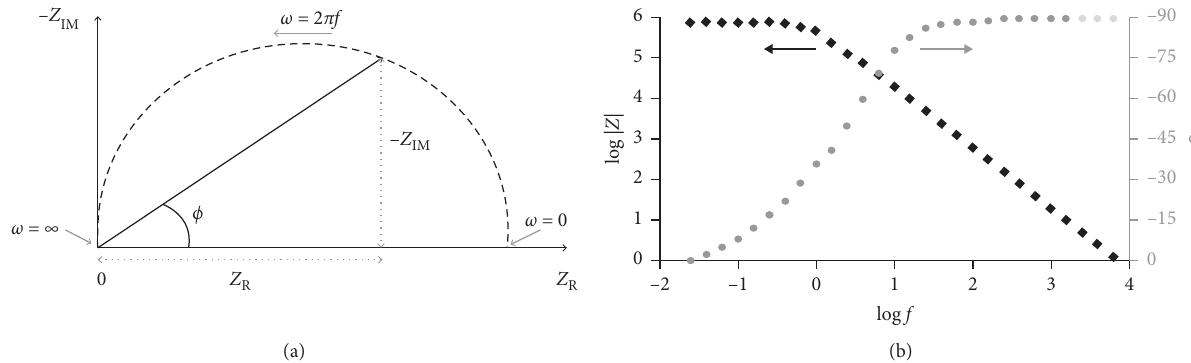
Figure 29: Representation of EIS (a) Nyquist and (b) Bode plots [162].